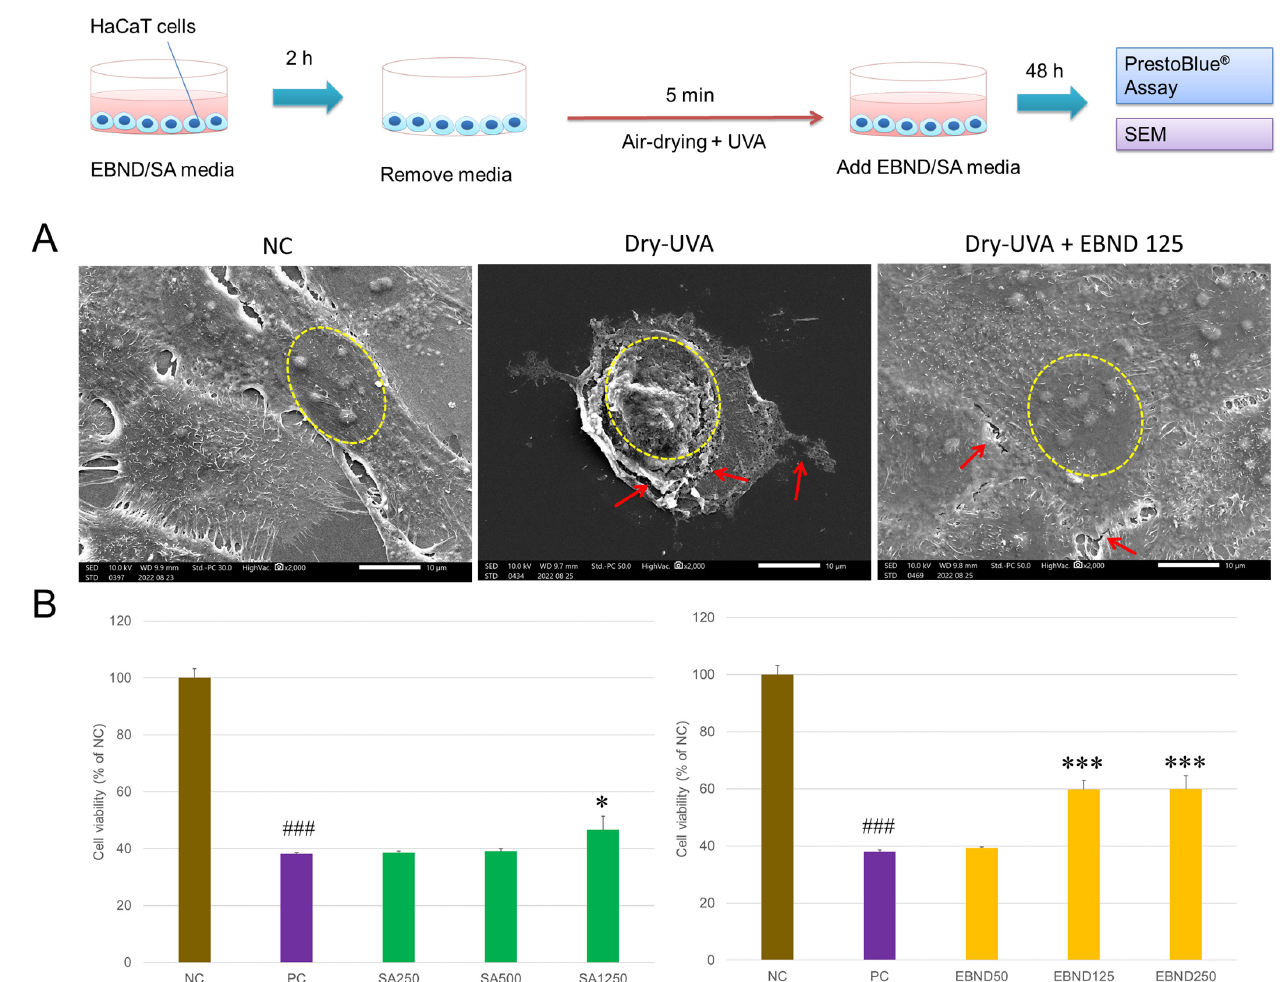
Figure 2. Effects of EBND and SA on air-drying- and UVA- induced cellular membrane damage and cell death in HaCaT cells. The top illustration represents the procedures for the experiments. HaCaT cells (2 × 10 4 cells/well) were seeded in 35 mm 2 4-chamber glass bottom dishes and treated with SA and EBND. At the end of the experiments, the microstructure of cell surfaces was observed by SEM. Cell viability was measured by PrestoBlue assay. ( A ) Typical SEM images of HaCaT cells at 48 h after UVA irradiation. Yellow circles indicate nuclei. Membrane breakages of cells were shown by red arrowheads. Scale bar = 10 µ m; ( B ) Cell viability of HaCaT cells. The negative control (NC) cells were cultivated in the maintenance medium without air-drying and UVA irradiation. The positive control (PC) cells were air-dried and UVA-irradiated without EBND or SA treatment. SA250, SA 250 µ g/mL; SA500, SA 500 µ g/mL; SA1250, SA 1250 µ g/mL; EBND 250, EBND 250 µ g/mL; EBND 125, EBND 125 µ g/mL; EBND 50, EBND 50 µ g/mL. The rests are the same. ### p < 0.001 vs. NC; * p < 0.05, *** p < 0.001 vs. PC. Each bar represents the mean ± SD of the three independent